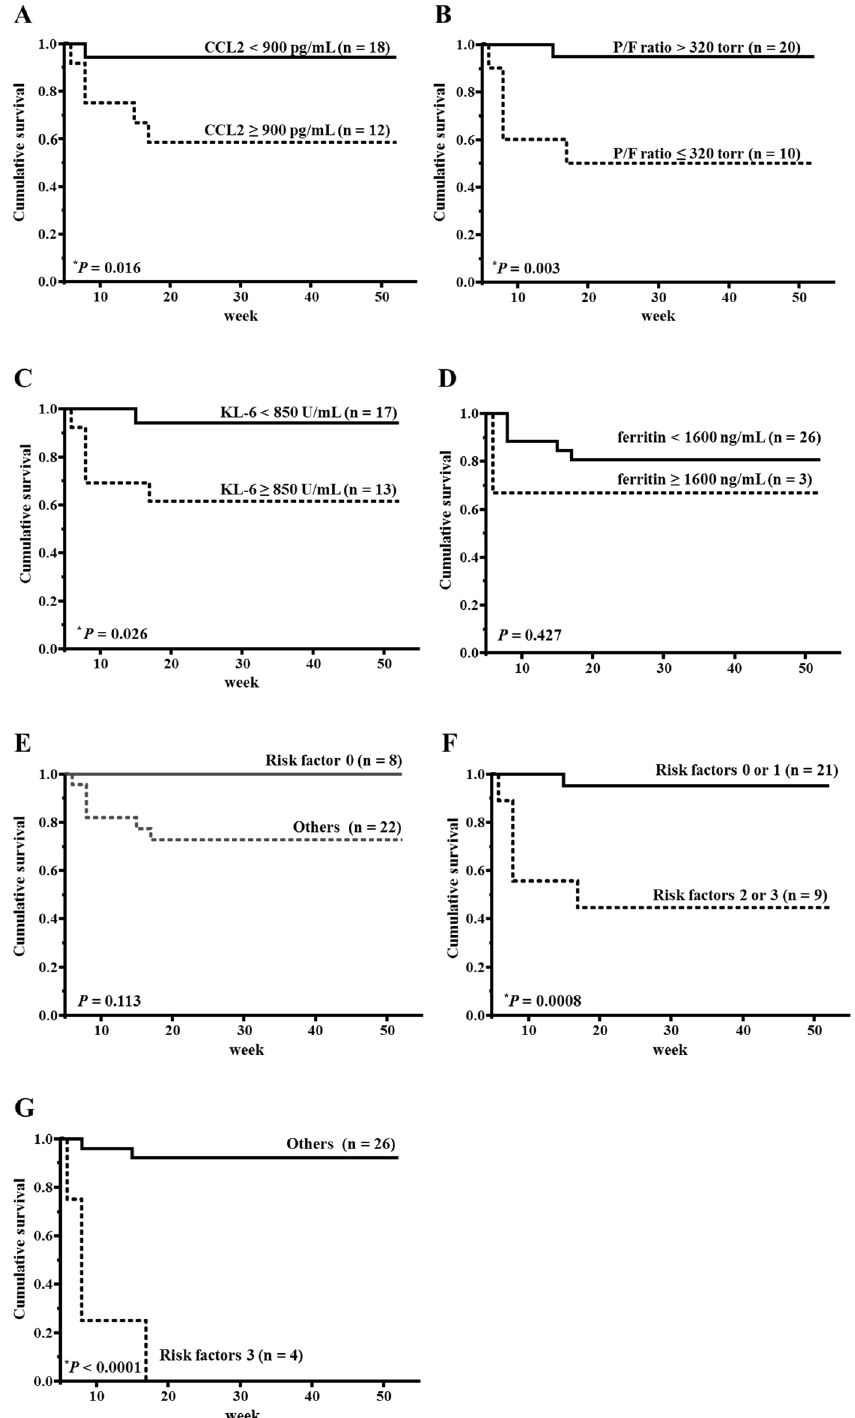
Figure 1. Survival curve of patients based on their initial serum CCL2 levels, P/F ratio, KL-6, and ferritin. ( A ) Survival curve of patients based on their initial serum CCL2 levels (solid line: < 900 pg/mL; dashed line: ≥ 900 pg/mL). ( B ) Survival curve of patients based on their initial P/F ratio (solid line: > 320 torr; dashed line: ≤ 320 torr). ( C ) Survival curve of patients based on their initial KL-6 (solid line: < 850 mmHg; dashed line: ≥ 850 mmHg). ( D ) Survival curve of patients based on their initial ferritin (solid line: < 1600 ng/mL; dashed line: ≥ 1600 ng/mL). ( E ) Survival curve of patients based on their initial risk factors (solid line: 0 risk factors; dashed line: others). ( F ) Survival curve of patients based on their initial risk factors (solid line: 0 or 1 risk factor; dashed line: 2 or 3 risk factors). ( G ) Survival curve of patients based on their initial risk factors (solid line: others; dashed line: 3 risk factors). CCL: C-C motif chemokine ligand; P/F: PaO 2 /FiO 2 . Survival rates were calculated by the Kaplan-Meier method and compared by log-rank test. * P <